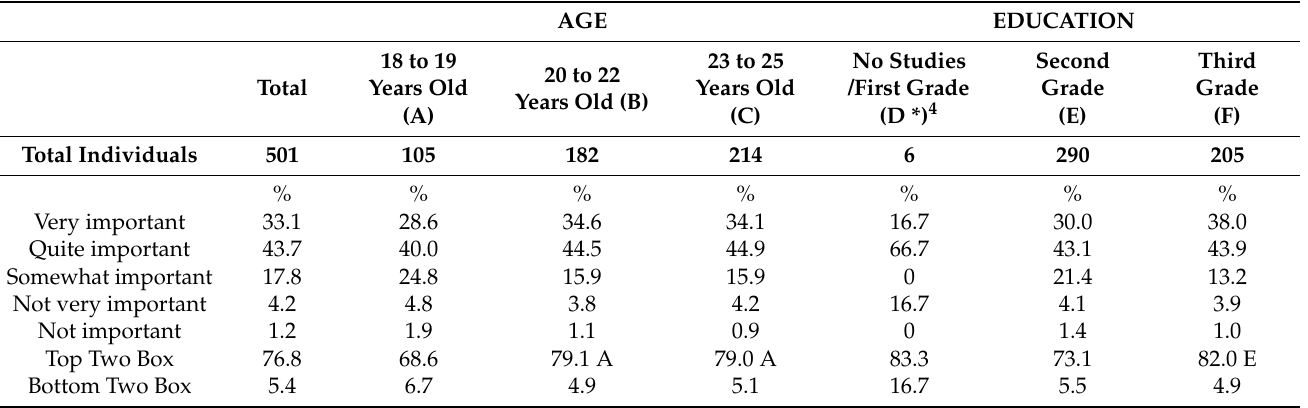
Table 2. Question 15: How important is it to be trained in the detection of fake